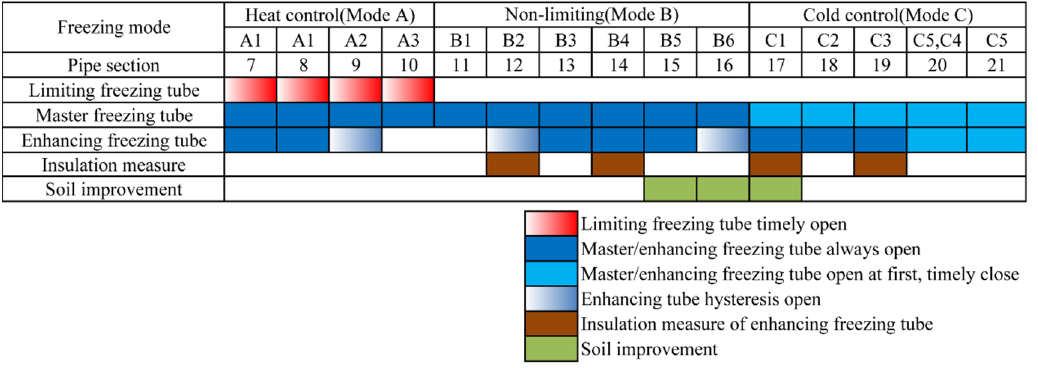
Figure 7. The arrangement of freezing Figure 7 . The arrangement of freezing scheme.